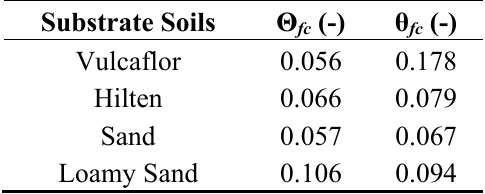
Table 2. Field capacity value of selected